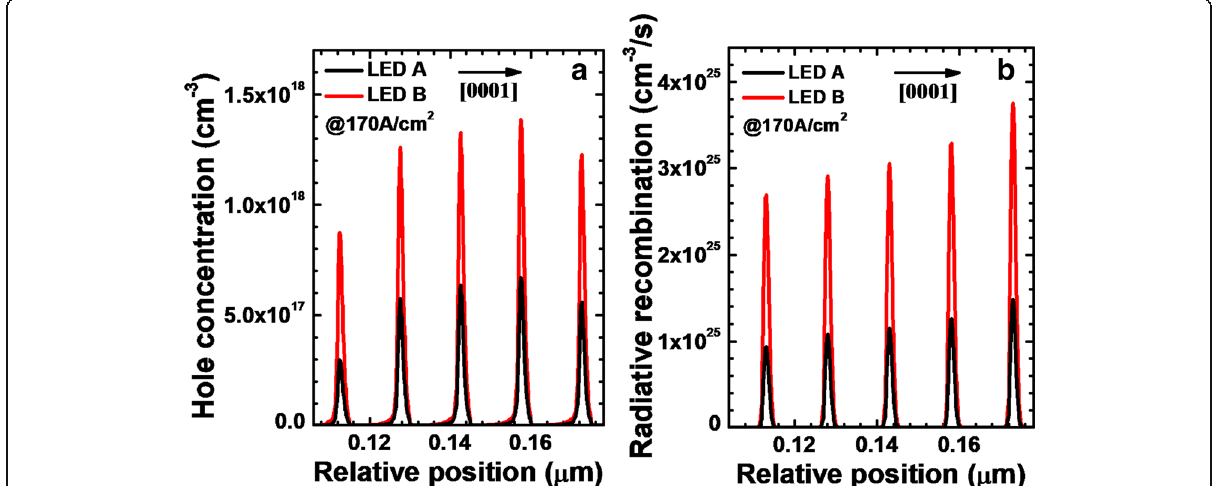
Fig. 4 a Hole concentration levels and b radiative recombination profiles in the MQWs for LEDs A and B, respectively. We collect the data at the location of 120 μ m away from the right edge of the mesa when the current density is 170 A/cm